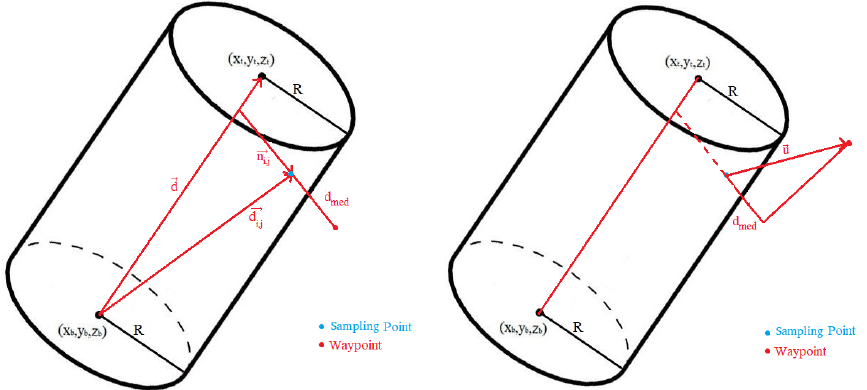
Figure 5. Input data to get the waypoints: ( left ) orthogonal, ( right ) constant tilt and